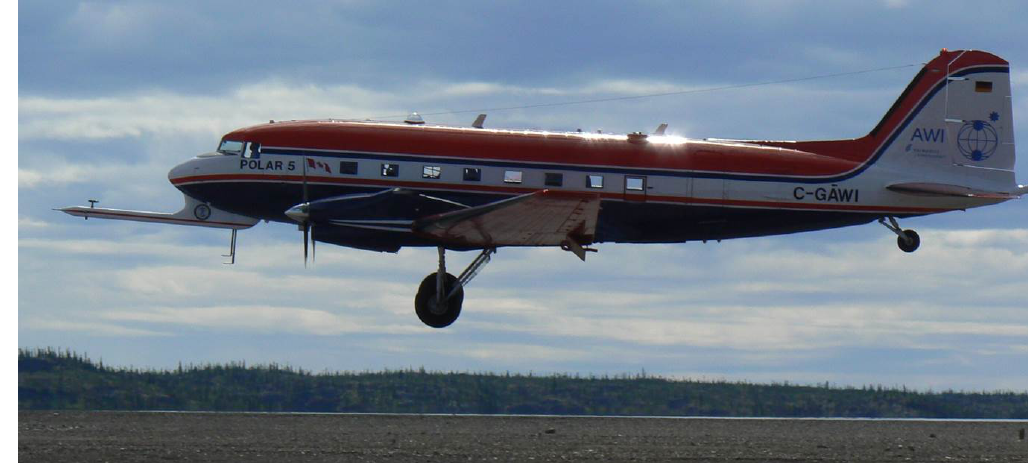
Figure 3: Polar5 with 5-hole probe at the noye boom, Photo: Alfred-Wegener-Institut/C.